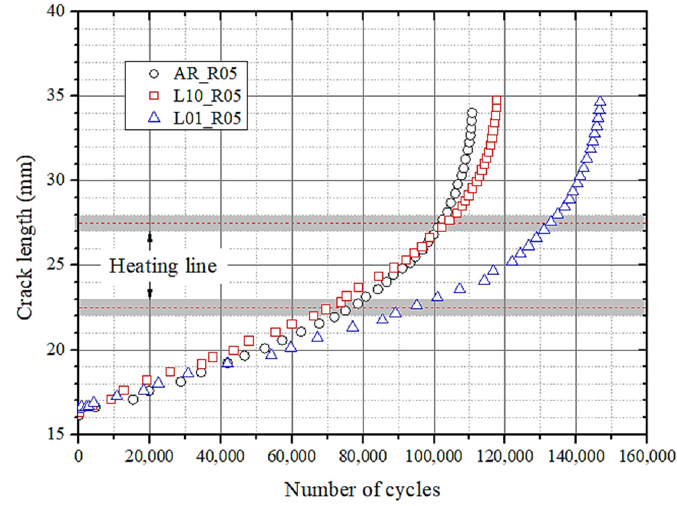
Figure 5. FCG test results: crack length vs. number of cycles for R = 0.5. It is noticeable that a crack arrest occurred in L01-R01 FCG test (Figure 4), which was interrupted after approximately 115,000 cycles and 3 mm crack length increase. A deviation of 12 ◦ was observed in the arrested crack growth direction, after an initial growth normal to the loading direction. The other test conditions did not show significant crack deflection. The drop in the crack growth rate can be also observed in Figure 6, in which da / dN calculated by the secant method is plotted against crack size for the R = 0.1 tests. The maximum load in that test was then increased from 800 N to 1.1 kN and the test was resumed. Another L01-R01 test with increased load ( P max = 1.6 kN) was also performed from the beginning for the da / dN - ∆ K analyzes. The calculations of ∆ K were done according to ASTM E647-15e1.